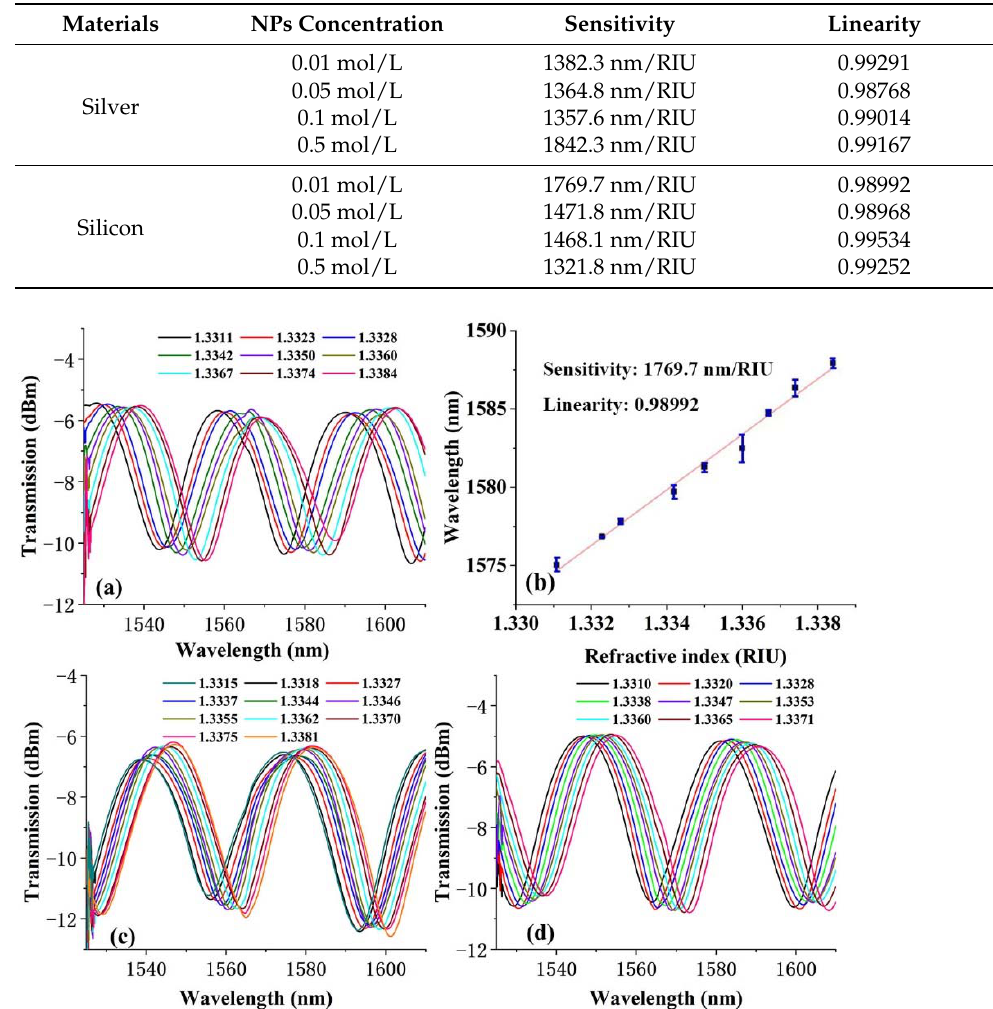
Figure 5. ( a ) Interference spectra as a function of refractive index and ( b ) corresponding fitting curve for microfiber taper elaborated by silicon NPs with a concentration of 0.01 mol/mL. ( c , d ) Interference spectra for other two probes with similar morphological parameters and coating layers.